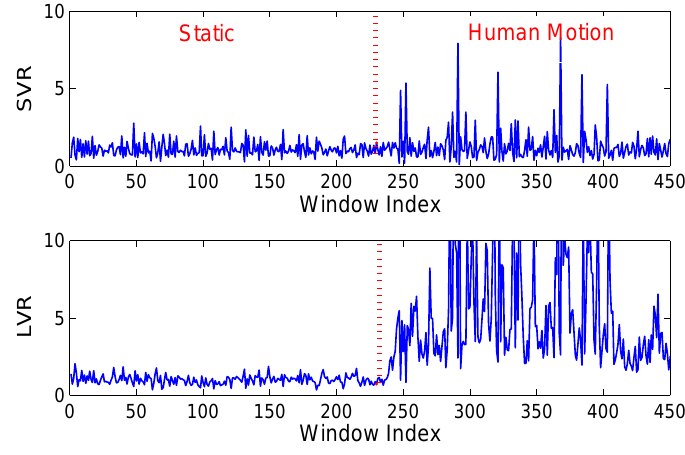
Figure 10. Variance of phase in static/dynamic